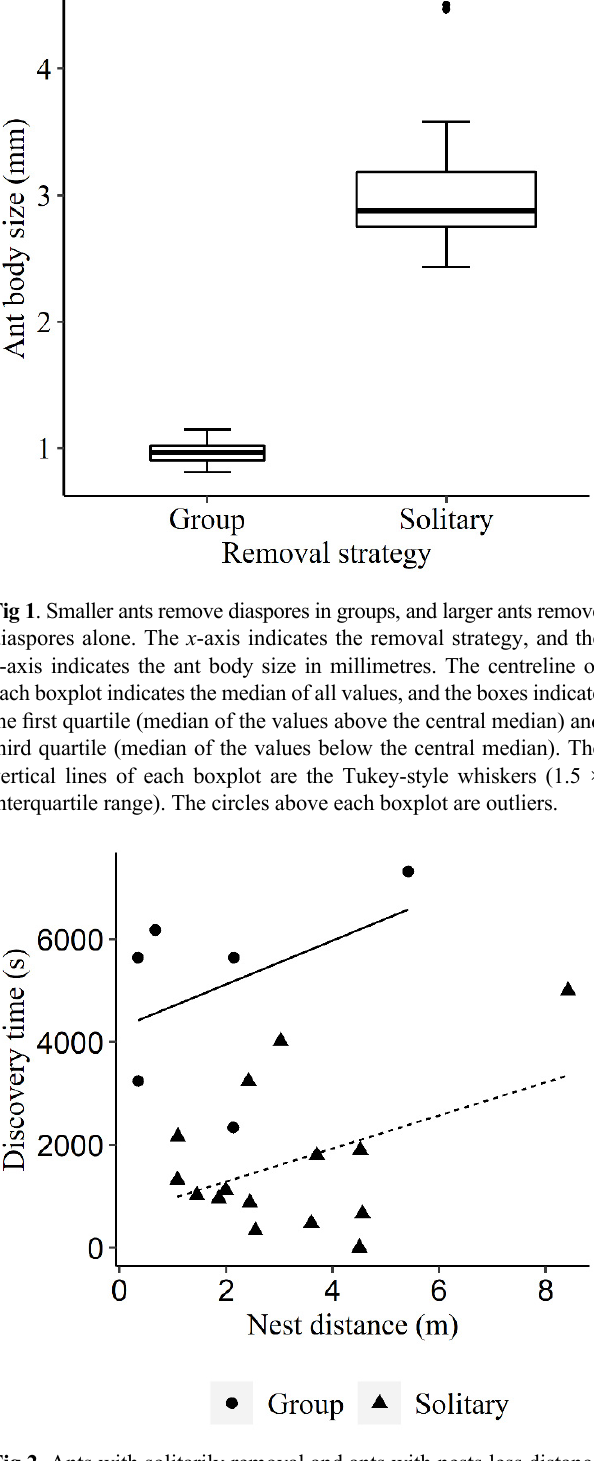
Fig 2 . Ants with solitarily removal and ants with nests less distance discover diaspores faster. The x -axis indicates nest distance in meters (m) the removal strategy (solitary and group), and the y -axis indicates the diaspore discovery time in seconds (s). The circles and the line indicate group removal ants, and the triangles and dashed line indicate solitary remover ants.